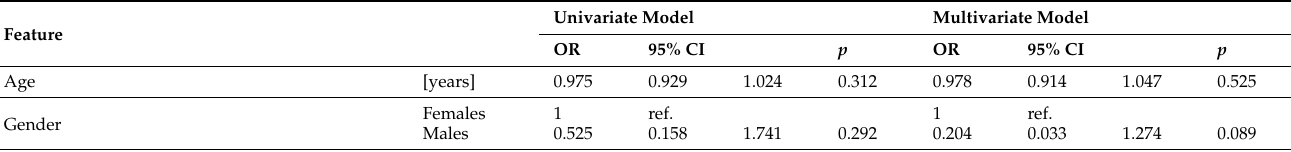
Table 7. Results of multivariate logistic regression for risk factors predicting scarcely symptomatic, symptomatic, or severe